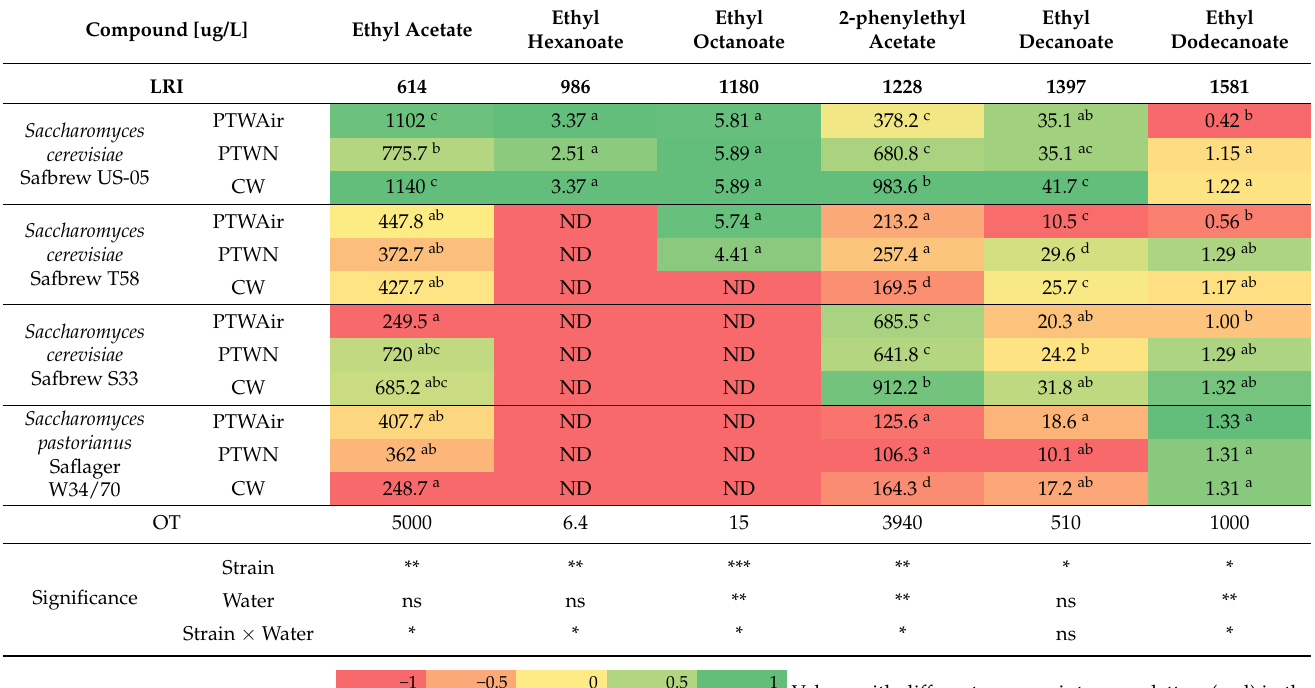
Table 4. Esters in beers fermented by Saccharomyces cerevisiae (T58, US-05, S33) and Saccharomyces